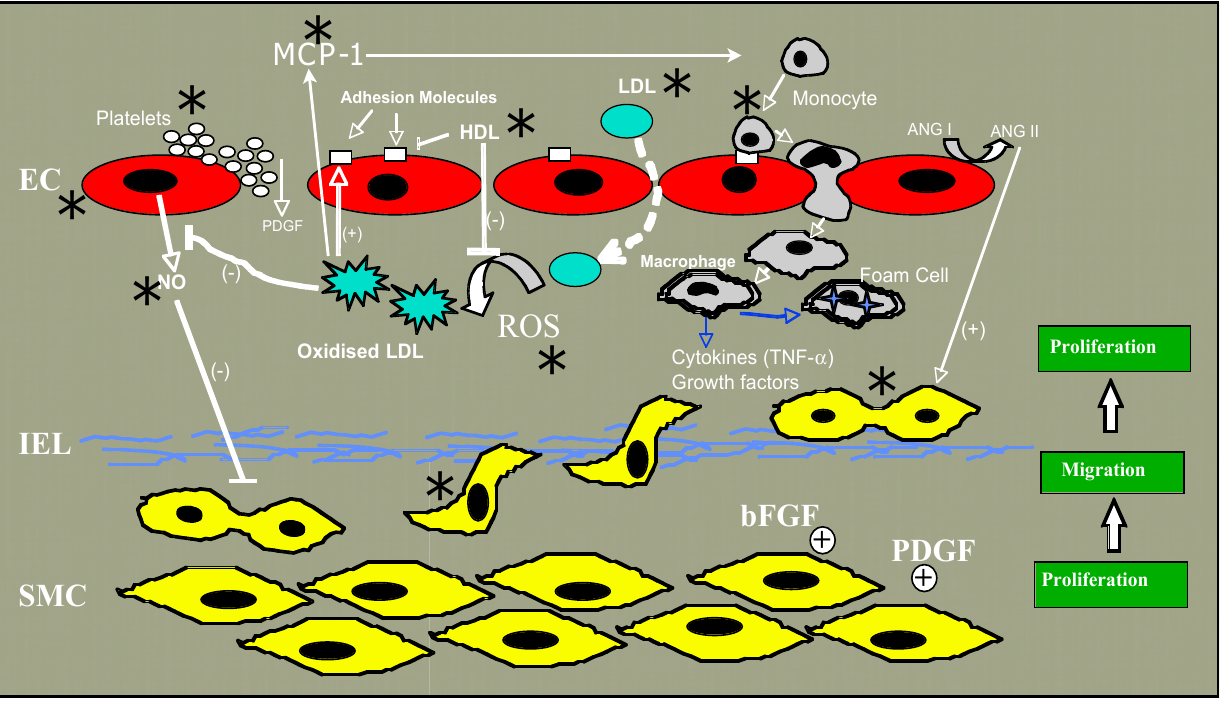
Figure 1. Steps in atherogenesis affected by ethanol are indicated by an asterix